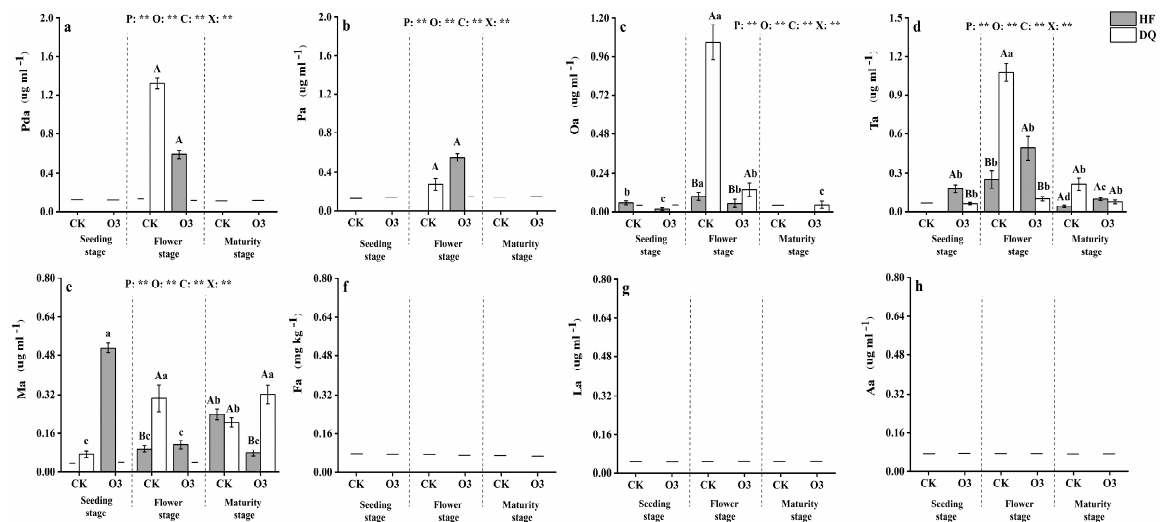
Figure 3. Content of organic acid in rhizosphere soil of DQ and HF tartary buckwheat at seedling, flowering, and maturity stages. ( a ) the content of malonic acid in rhizosphere soil of DQ and HF tartary buckwheat at seedling, flowering, and maturity stages. ( b ) the content of propionic acid in rhizosphere soil of DQ and HF tartary buckwheat at seedling, flowering, and maturity stages. ( c ) the content of oxalic acid in rhizosphere soil of DQ and HF tartary buckwheat at seedling, flowering, and maturity stages. ( d ) the content of tartaric acid in rhizosphere soil of DQ and HF tartary buckwheat at seedling, flowering, and maturity stages. ( e ), the content of malic acid in rhizosphere soil of DQ and HF tartary buckwheat at seedling, flowering, and maturity stages. ( f ) the content of formic acid in rhizosphere soil of DQ and HF tartary buckwheat at seedling, flowering, and maturity stages. ( g ) the content of lactic acid in rhizosphere soil of DQ and HF tartary buckwheat at seedling, flowering, and maturity stages. ( h ) the content of acetic acid in rhizosphere soil of DQ and HF tartary buckwheat at seedling, flowering, and maturity stages. DQ represents low soil nutrient tolerant variety and HF represents low soil nutrient sensitive variety. Bars with different letters indicate a significant difference in the least significant difference (LSD) tests ( p < 0.05) between different cultivars (capital letters) and treatments (small letters). P means treatment period, O means treatment effect, C means cultivar effect, and X means interactive effects of treatment, period, and cultivar. ** indicates a significant difference ( p < 0.01), and ns indicates no significant difference ( p > 0.05). Pda, malonic acid; Pa, propionic acid; Oa, oxalic acid; Ta, tartaric acid; Ma, malic acid; Fa, formic acid; La, lactic acid; Aa, acetic acid.